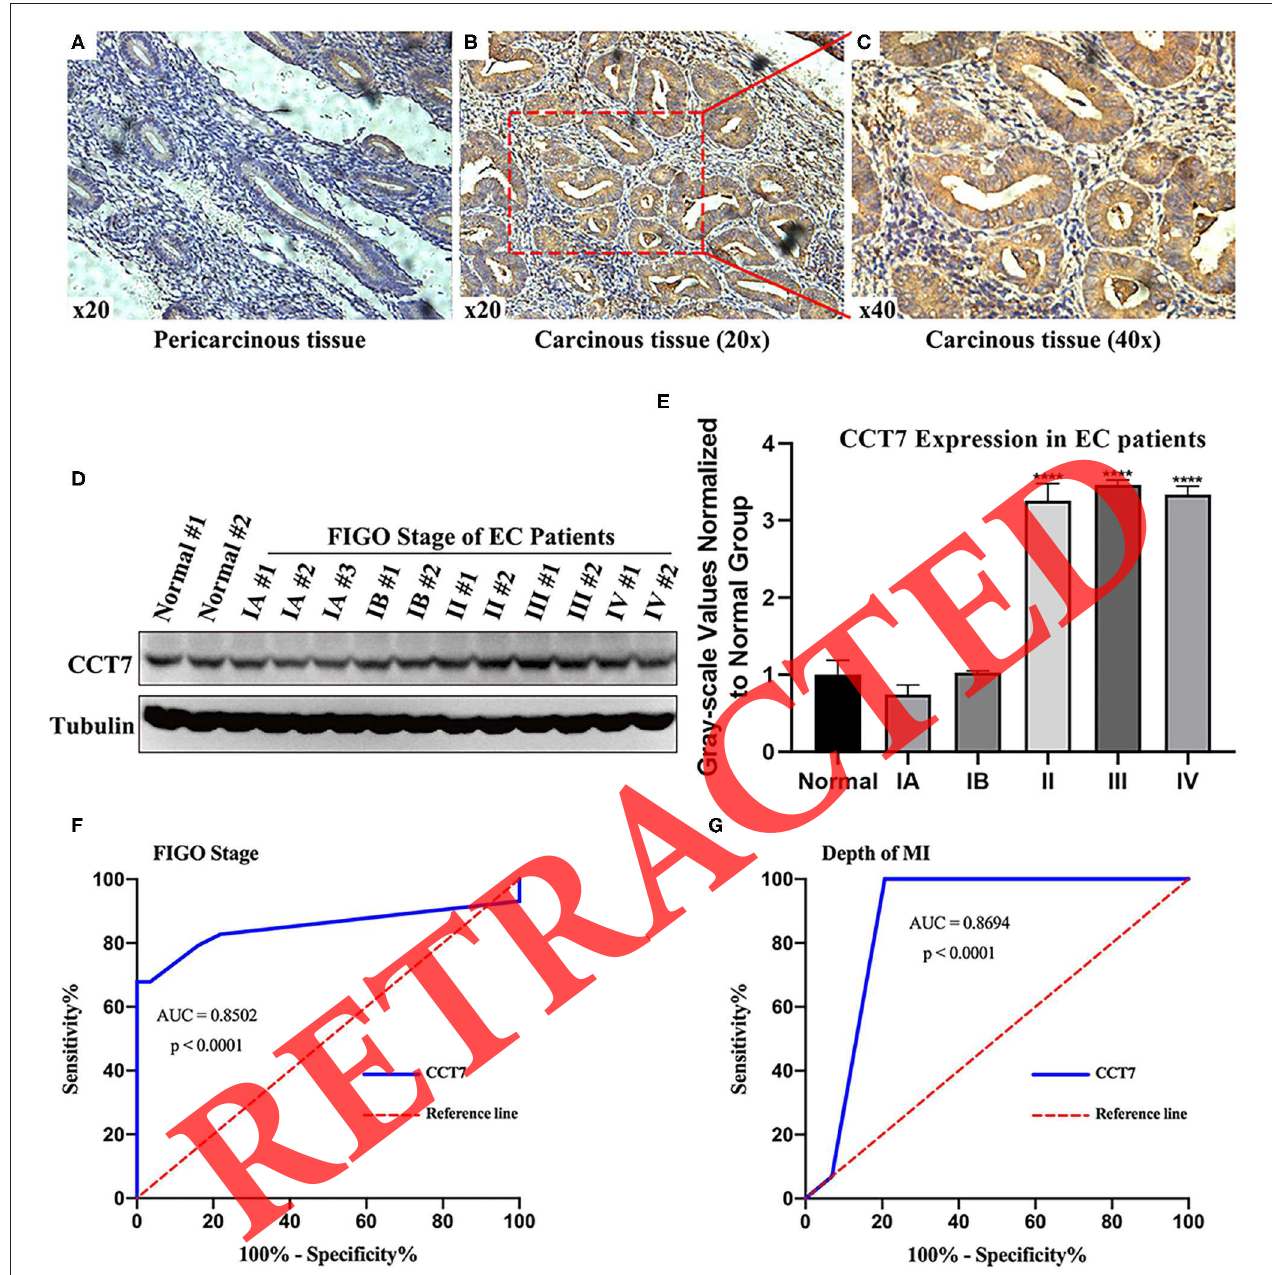
FIGURE 1 | CCT7 Overexpression in Carcinous Tissue. Immunohistochemistry assay for CCT7 in pericarcinous tissue (A) and carcinous tissue ( B : 20x and C : 40x). Western blotting assays were used to evaluate the expression of CCT7 level in the samples from EC patients (D) , quantification also performed (E) . Receiver operating characteristic curves (ROCs) were used to analyzed the association between CCT7 expression and FIGO stage and MI depth (F,G) . **** p < 0.0001, all values represent Mean ± S.D.